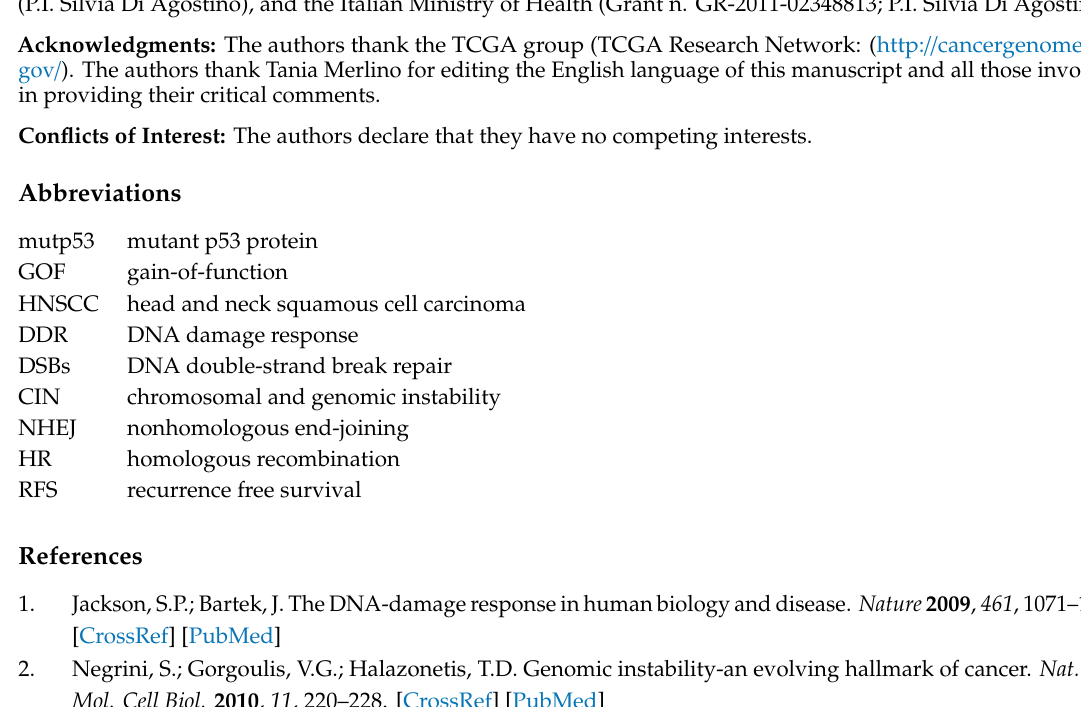
Figure S1: Rad17 and BRCA1 are targets of miR-205-5p; Figure S2: miR-205-5p a ff ects the proliferation of cells; Figure S3: 53BP1 protein expression in cells overexpressing miR-205-5p; Figure S4: miR-205-5p expression from non-tumoral and matched tumoral tissue in the sub-groups of HNSCC patients with wild type and mutant p53 protein; Table S1: Comparative view of predicted miRNA sites on 3’ UTR region by miRWalk and other prediction programs; Table S2: Results of Pearson correlation analysis relative to BRCA1 and RAD17 in HNSCC samples from TCGA; Table S3: Fisher analysis relative to the dependence of BRCA1 and RAD17 expression in the HNSCC mutp53 and wtp53 subgroups; Table S4: Fisher analysis relative to the dipendence of miR-205 / BRCA1 and miR-205 / RAD17 expression in the HNSCC mutp53 and wtp53 subgroups; Table S5: Primers used to clone RAD17 3’ UTR in psiCHEK2 vector; Table S6: Primer sequences for amplification of cDNAs in real-time qPCR experiments; Table S7: Mutational status of TP53 gene in HNSCC tumors (cohort of Regina Elena National cancer Institute); Table S8: Gene set enrichment analysis (GSEA) functional